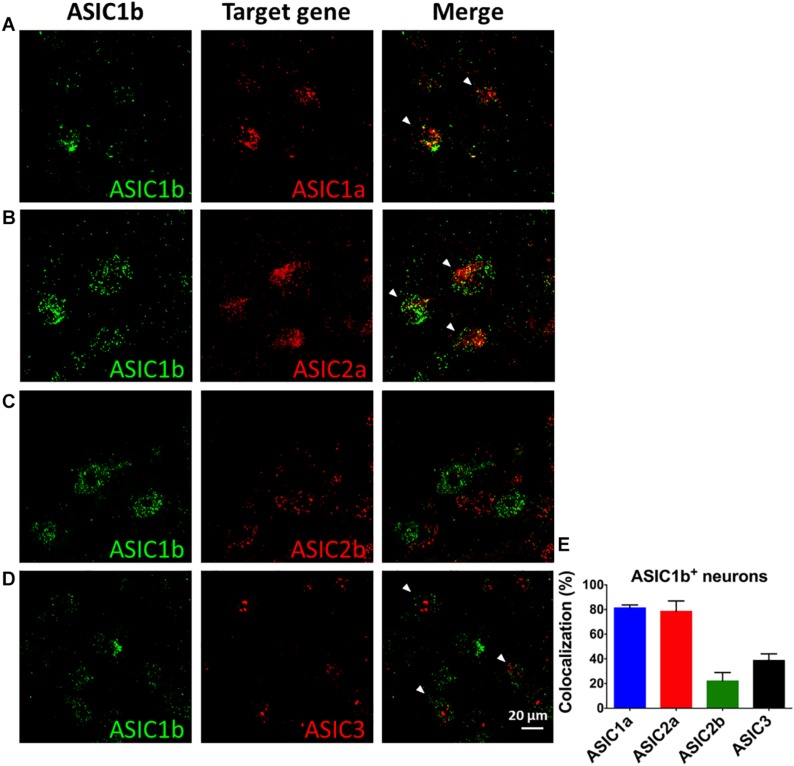
In situ hybridization of Asic1a, Asic1b, Asic2a, Asic2b, and Asic3 transcripts in L4 DRG neurons. (A–D) Triple in situ hybridization of Asic1b with Asic1a
(A) and Asic3
(D) in L4 DRG. Double in situ hybridization of Asic1b and Asic2a
(B), Asic1b and Asic2b
(C) in L4 DRG. White arrowheads indicate the co-localization of Asic1b with a target gene. (E) Quantification of the expression of Asic1a, Asic2a, Asic2b, and Asic3 in Asic1b-positive DRG neurons (N = 3 for each in situ hybridization combination). Data are mean ± SEM.